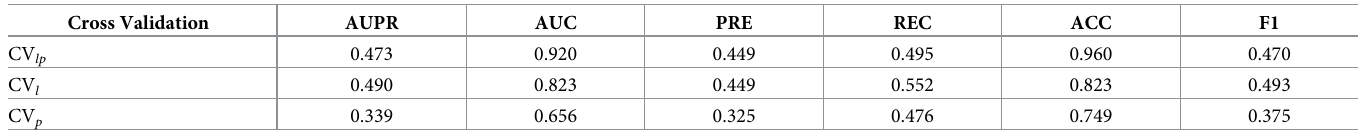
Table 1. Performances of SFPEL-LPI for predicting lncRNA-protein interactions. Cross